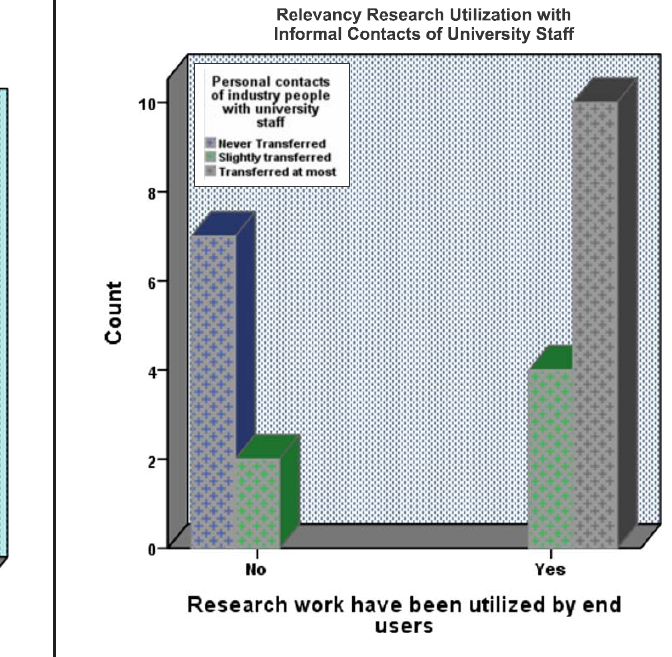
FIG. 4. ROLE OF PERSONAL CONTACTS OF ACADEMICS WITH INDUSTRY PEOPLE TOWARDS UTILIZATION OF